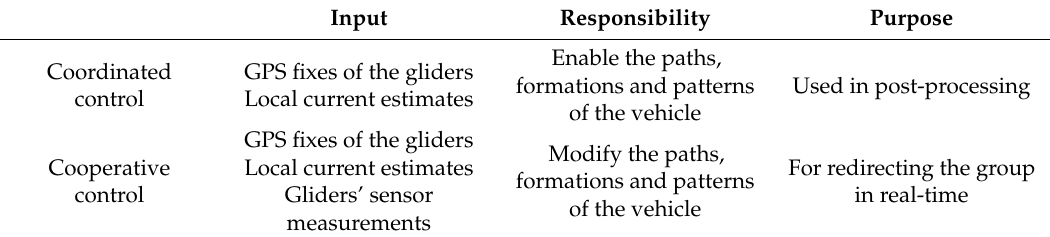
Table 14. Coordinated control and cooperative control implemented in an adaptive sampling approach with multiple vehicles.